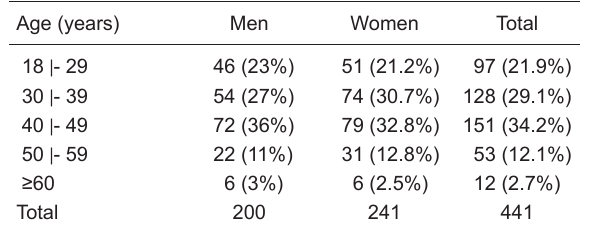
Table 1. Age distribution of the men and women of the study sample. Age (years)